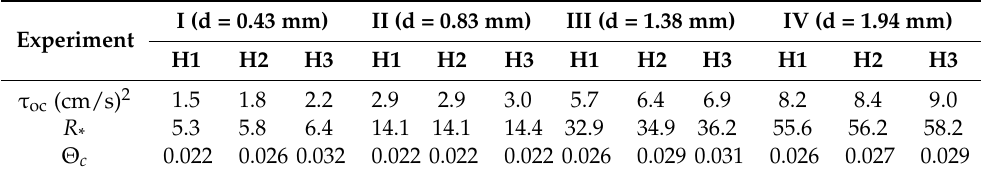
Figure 9. Reynolds shear stress − u (cid:48) w (cid:48) distributions under threshold condition (cm/s) 2 . Table 6. The critical shear stress, particle shear Reynolds number, and critical Shields parameter of the experiments.